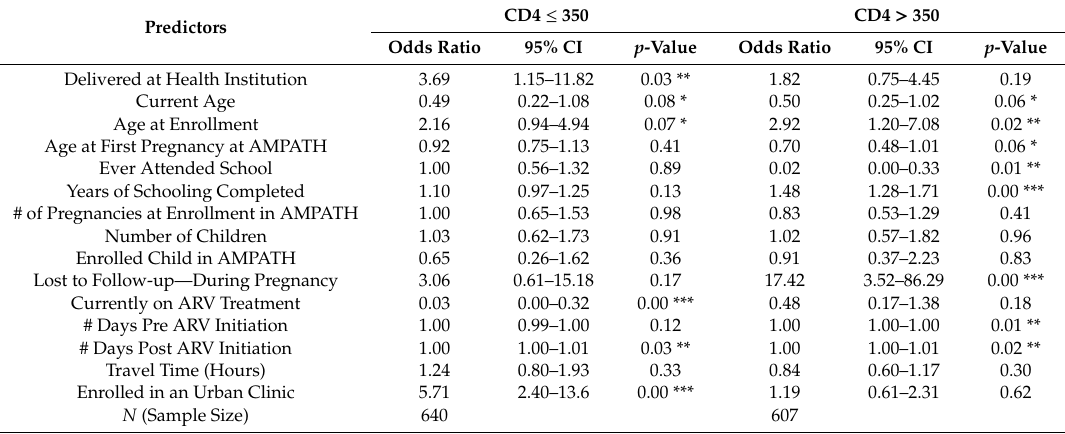
Table 4. Predictors of Insurance Enrollment among HIV positive Pregnant Women: By HIV Disease